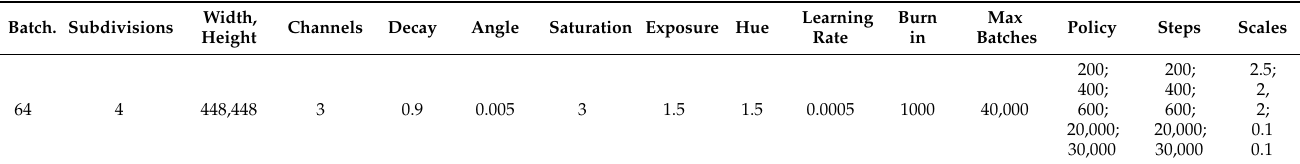
(1) image acquisition from a field surveillance camera, (2) object recognition using image processing, and (3) information matching in the system DB. The system algorithm is shown in Figure